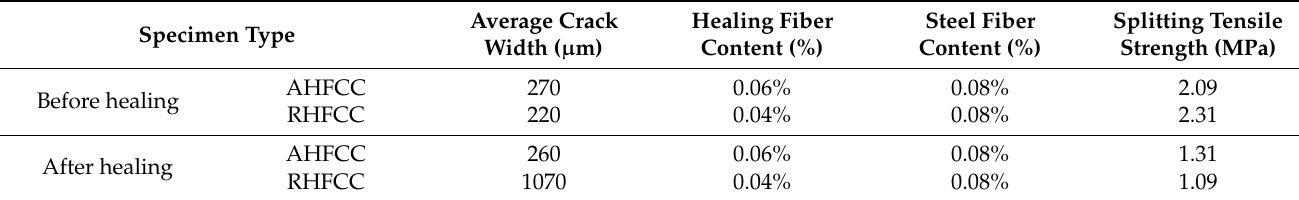
Figure 7. Healing capability evaluation: ( a ) splitting tensile strength before and after healing, ( b ) load – crack width rela- tionship after healing.